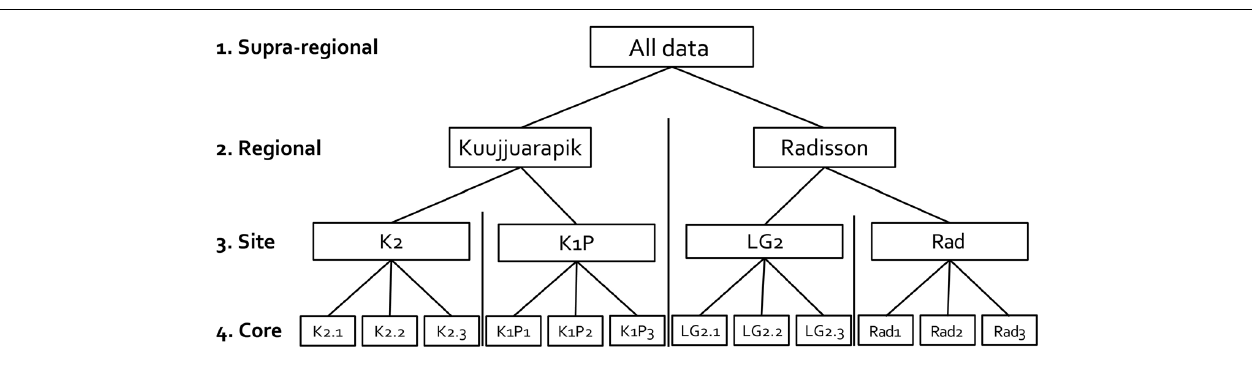
FIGURE 2 | Illustration showing the replicated site network design in this study. Numbered terms represent different spatial scales.